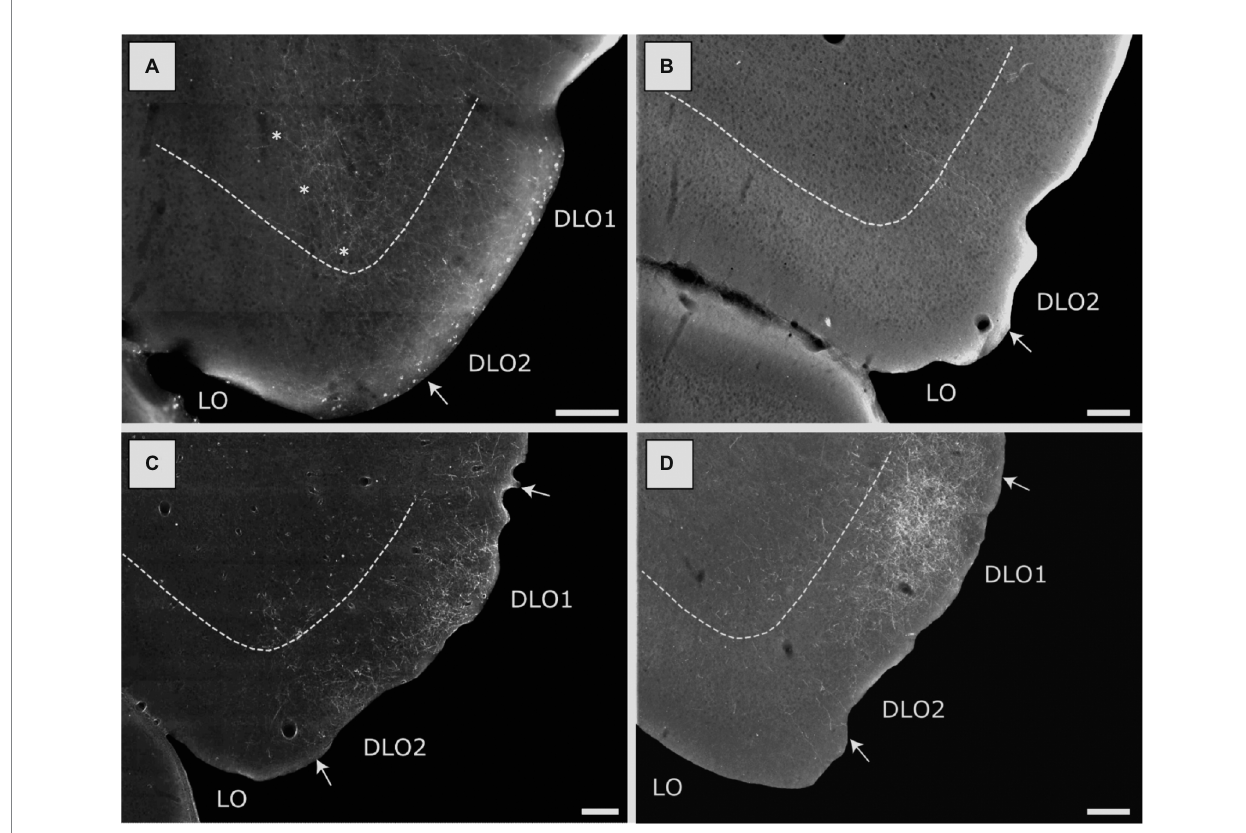
FIGURE 8 Image of labeled fibers in the lateral (LO) and dorsolateral (DLO) orbital fields, resulting from anterograde tracer injections into various portions of the insular cortex. (A) Distribution of terminal labeling following a BDA injection in the DI field of the posterior insular domain (case 15407B). Labeled fibers are particularly dense in the DLO2 field with more moderate labeling in the LO field. Asterisks indicate the LO/DLO border. (B) Distribution of terminal labeling following a BDA injection in the GI field of the posterior insular domain (15442B). Only very sparse labeling can be seen, located to the DLO2 field. (C) Distribution of terminal labeling following a BDA injection in the DI field of the parietal insular domain (18079B). In this case labeling is concentrated in both the DLO1 and DLO2 fields with virtual no labeling in other orbital fields. (D) Distribution of terminal labeling following a PHA-L injection in the GI field of the parietal insular domain (13347P). Although fiber labeling covers both DLO fields, it is heavily concentrated in DLO1. Among other orbital fields, only LO is sparsely labeled. Dashed lines indicate the border between layers 3 and 5. Scale bars equal 200 μ